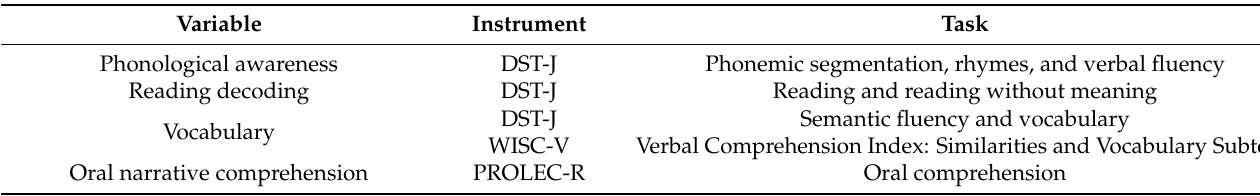
Table 1. Overview of the instruments used in the